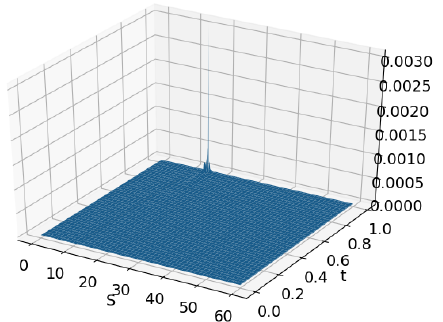
Figure 2. Error surface for the artificial neural network (ANN)